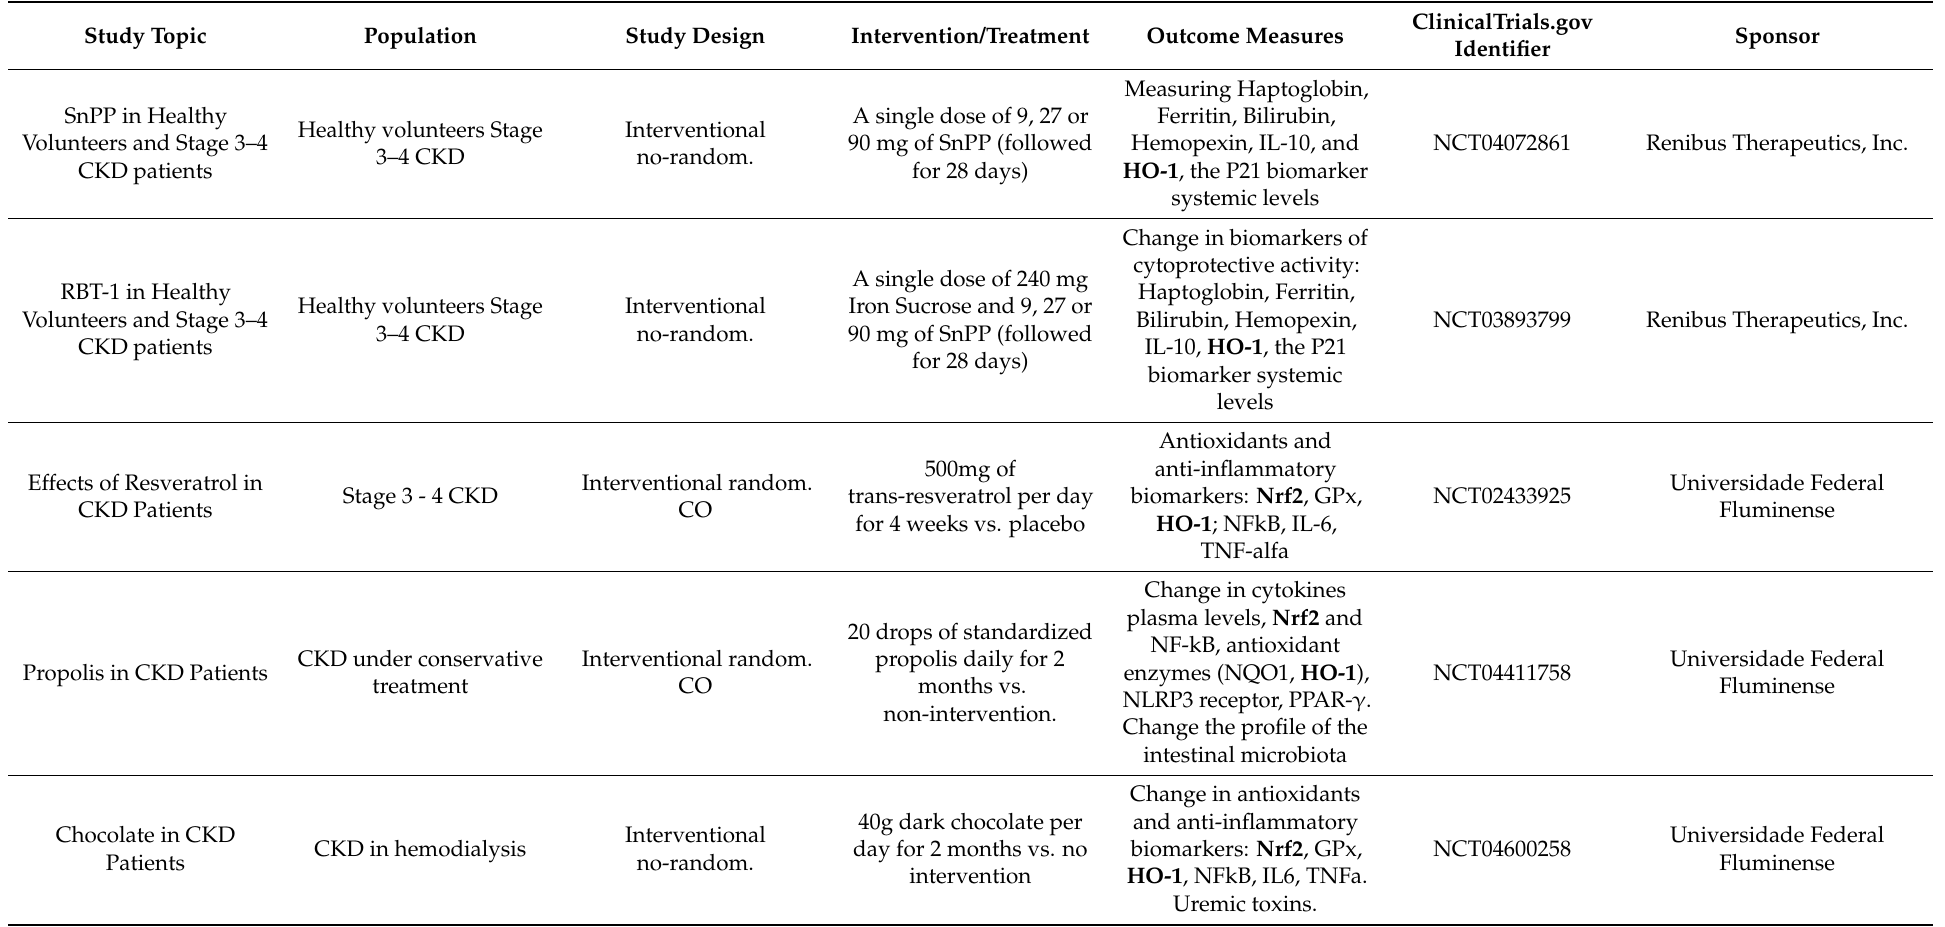
Table 2. Clinical trials for HO-1 and